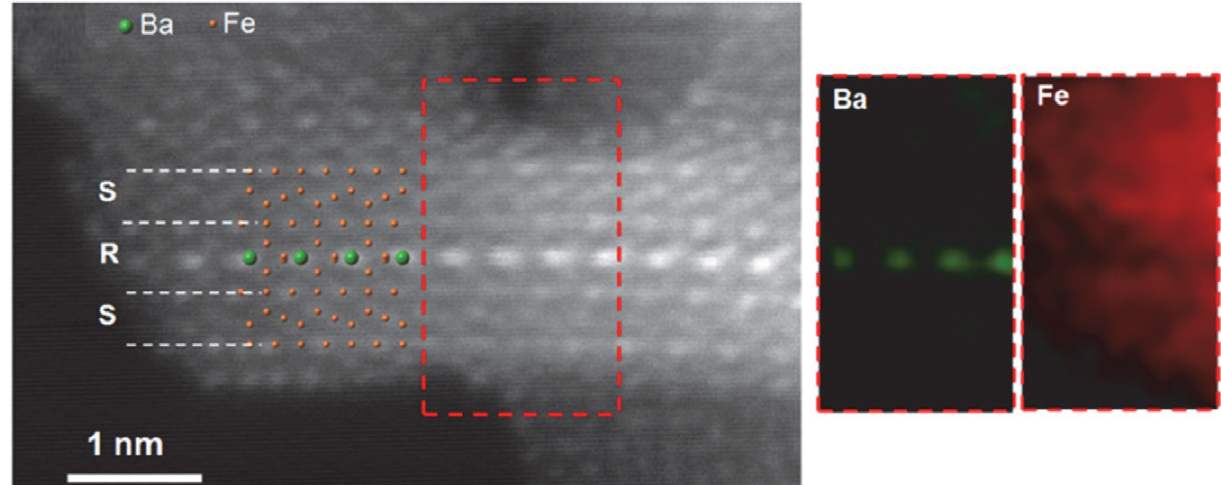
Figure 4. HAADF STEM images of a primary BHF NPL with corresponding EELS elemental maps for Ba and Fe (the area of the analysis is marked on the image with a red rectangle). An SRS * segment of the hexaferrite structure projected along the image to illustrate the positions of the Ba 2+ and Fe 3+ ions. ( Adapted from the publication by D. Makovec, B. Belec T. Goršak, D. Lisjak, M. Komelj, G. Dražić, S. Gyergyek, Nanoscale 2018, 10, 14480–14491 with permission from The Royal Society of Chemistry. 7